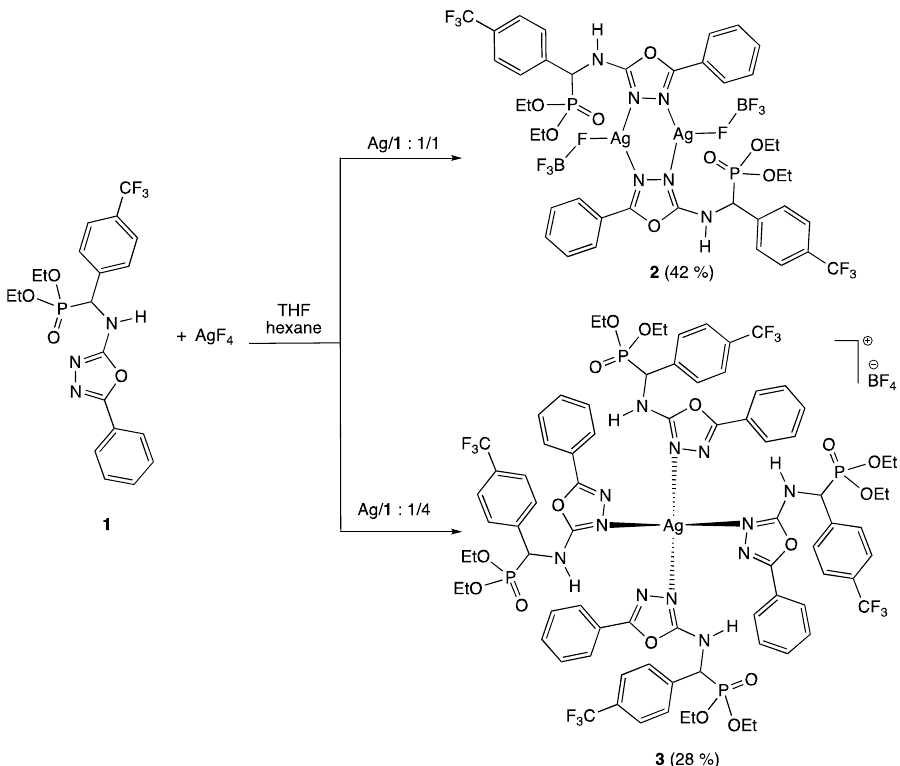
Figure 2. Mass spectrum (ESI ‐ TOF) of silver complexes; observed spectrum (Top) and simulated